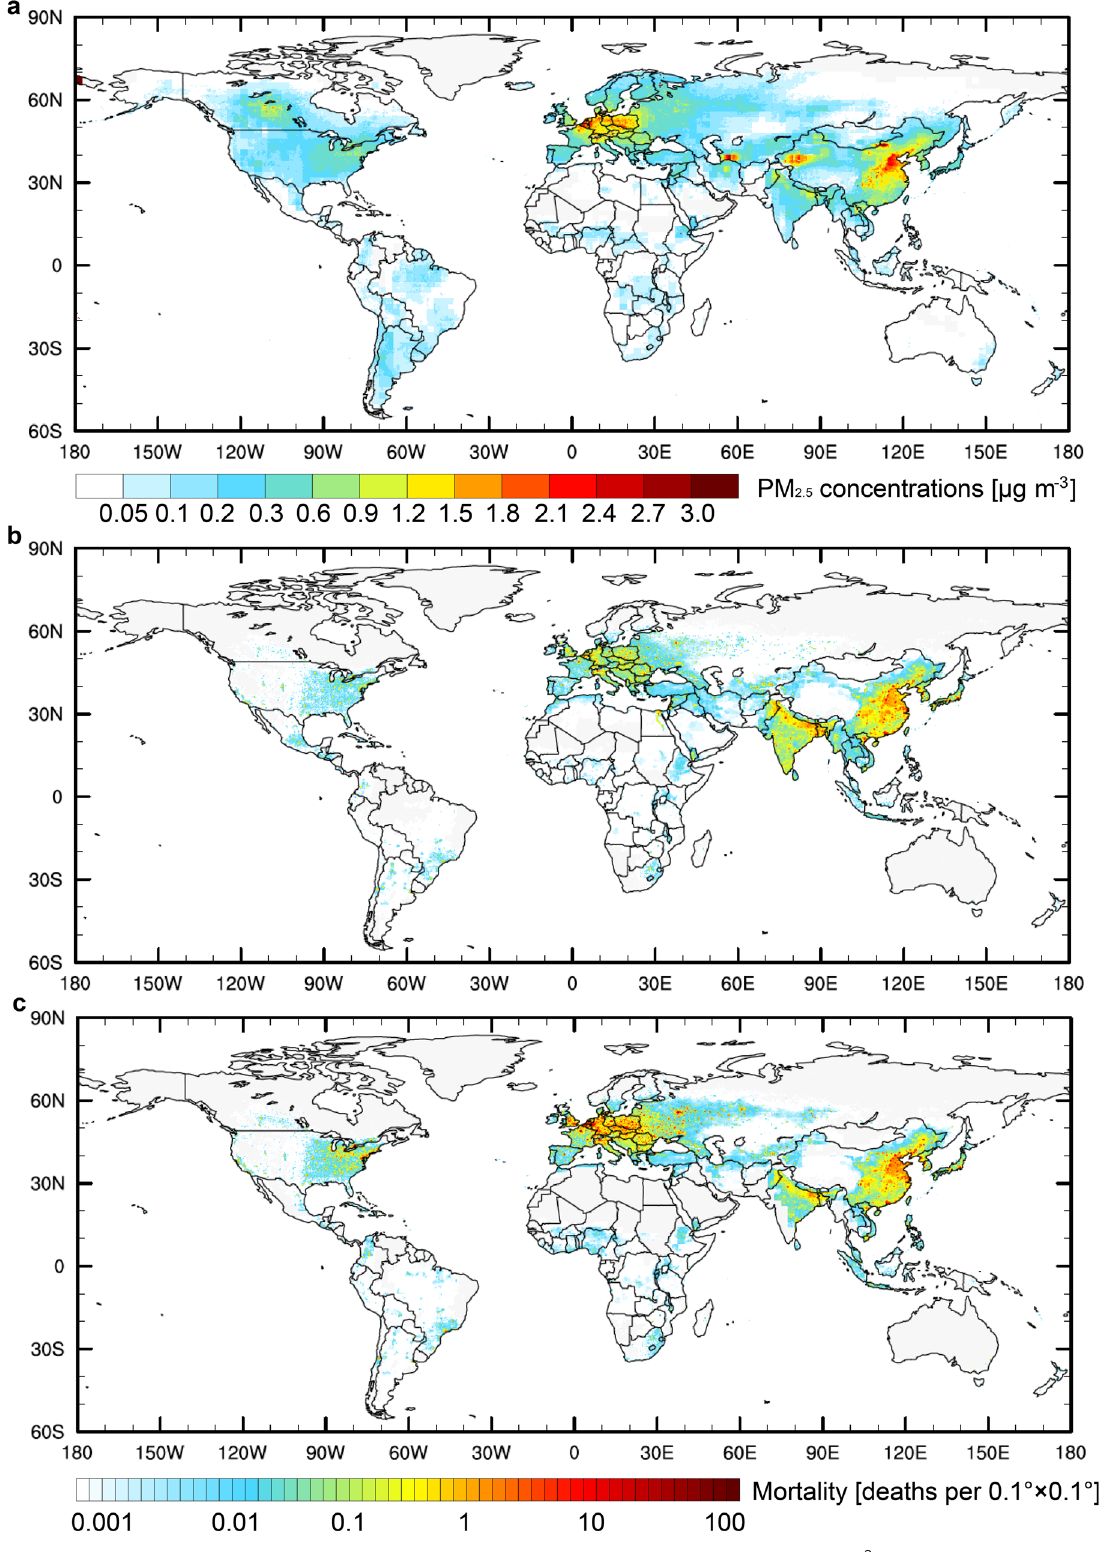
Fig. 2 Air quality and health impacts of export-related NH 3 emissions in 2012. a PM 2.5 concentrations ( μ g m − 3 ) induced by export-related NH 3 emissions in 2012 are calculated by GEOS-Chem simulations. Attributable premature mortality density (deaths per 0.1° × 0.1° a − 1 ) due to export-related NH 3 emissions from b crop production and c livestock production. The attributable premature mortality is determined by GEOS-Chem modeled fractional contributions of export-driven NH 3 emissions to total PM 2.5 and the calibrated high-resolution PM 2.5 data from GBD 2013 26 . Premature mortality on a resolution of 0.1° × 0.1° is estimated following the methods of the GBD study to estimate the premature deaths from ambient PM 2.5 exposure (see “ Methods ” ). Maps were created by using the NCAR Command Language, version 6.4.0 (NCAR,